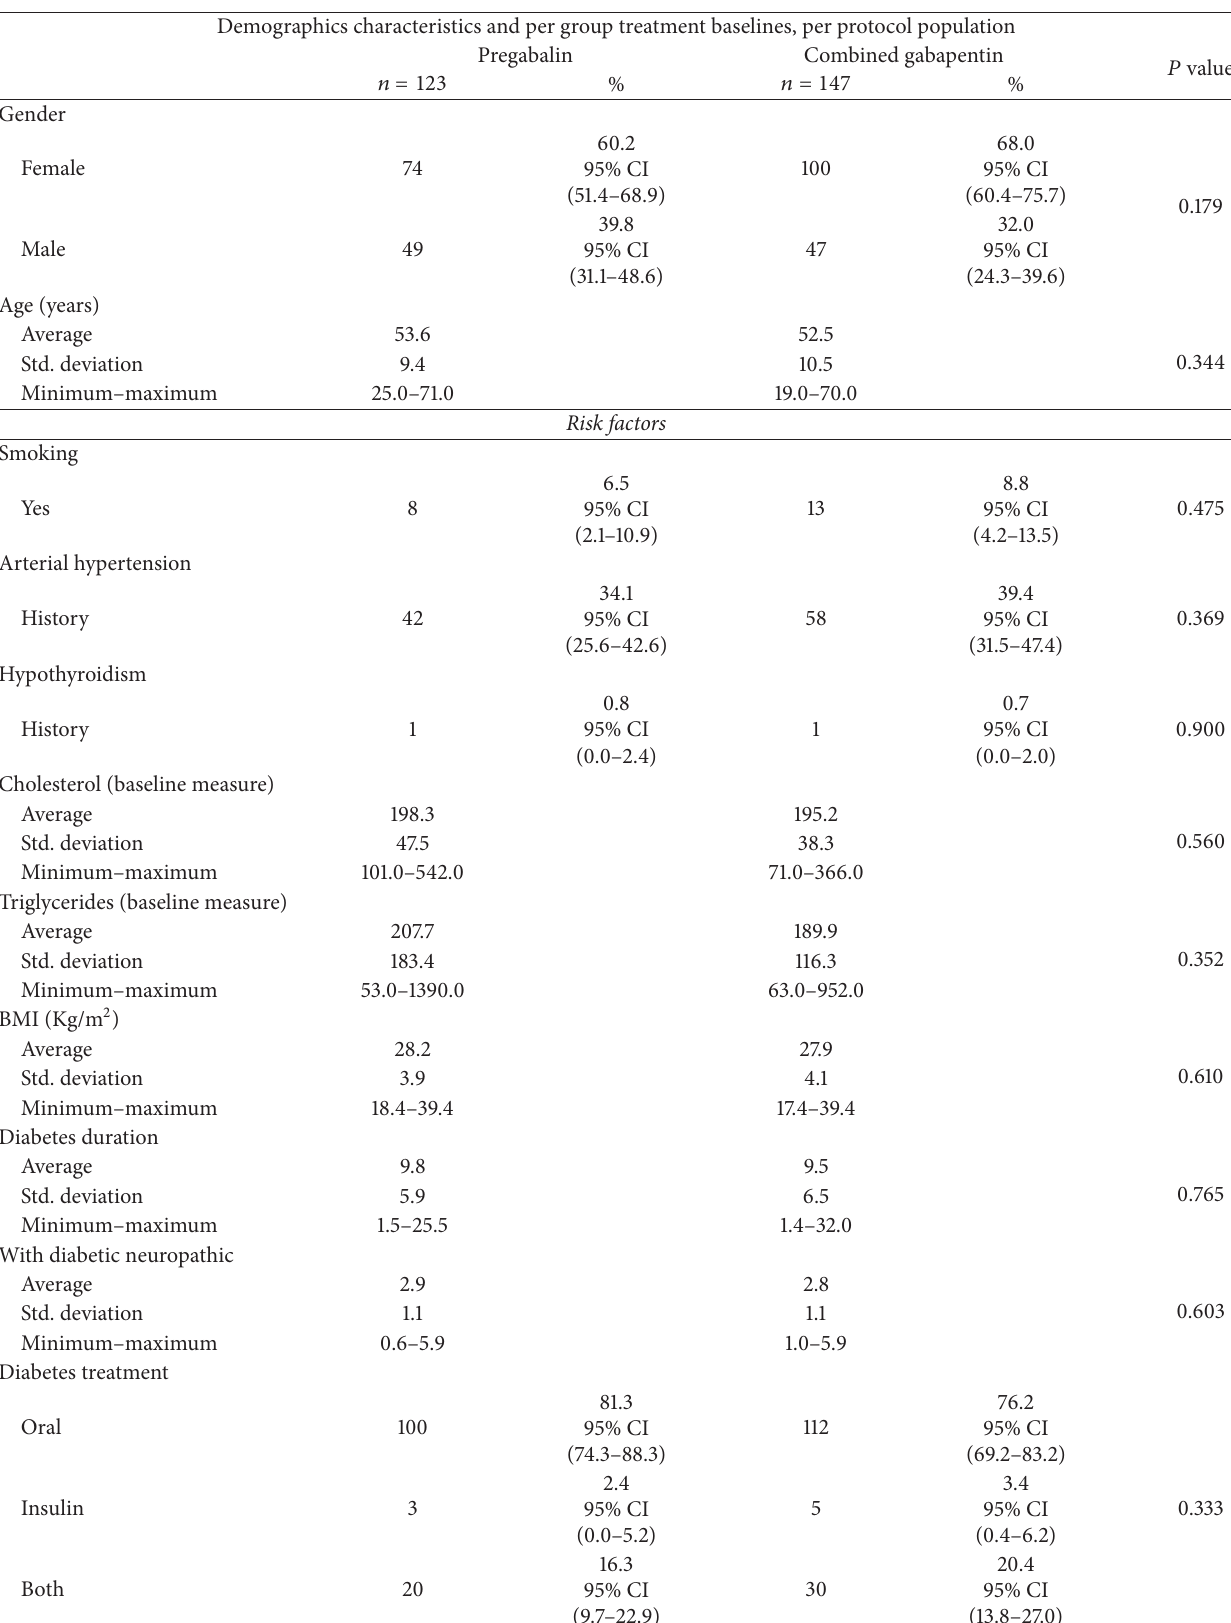
Table 1: Demographics characteristics and per group treatment characteristics ( 𝑛 = 270